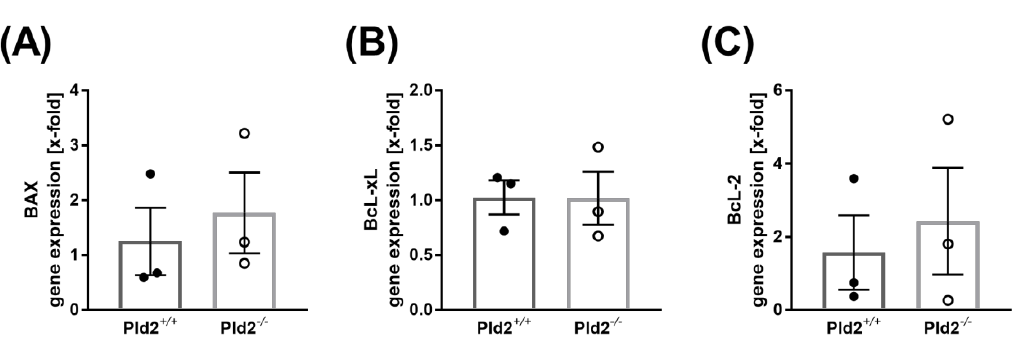
Figure 5. Expression of pro- and anti-apoptotic proteins after I / R. ( A ) Expression of the pro-apoptotic protein Bax and ( B,C ) the anti-apoptotic proteins Bcl-2 ( B ) and Bcl-xL ( C ) in the left ventricle of Pld2 +/+ and Pld2 − / − mice 24 h after I / R, n = 3. Bar graphs depict mean values ± SEM. Statistical analysis was performed using a two-tailed Student’s t -test.